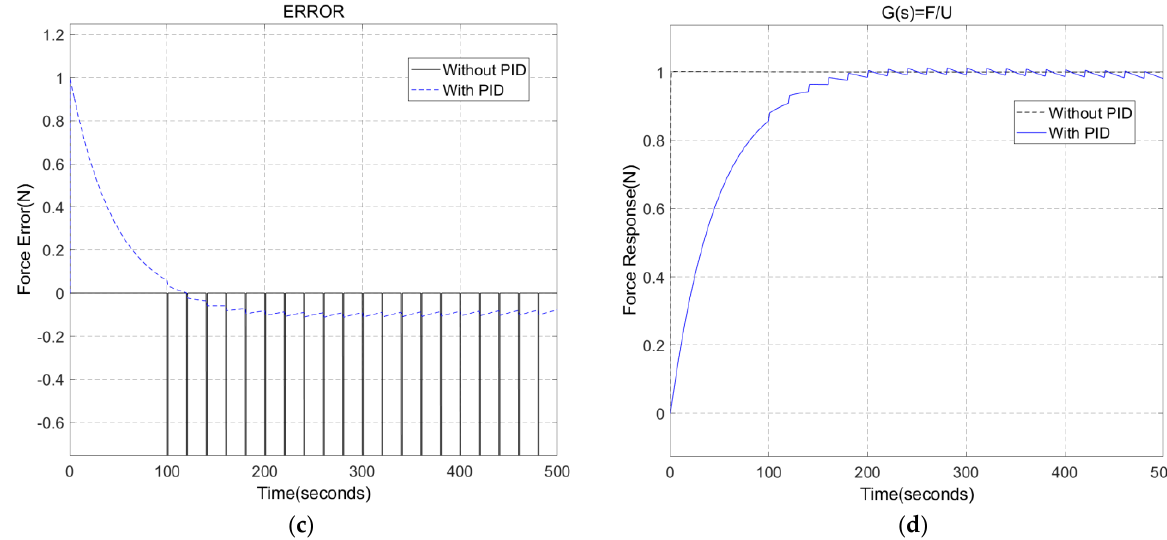
Figure 19 . Force response curves with interference. ( a ) Interference signal; ( b ) Force response curves with interference; ( c ) Error curves with and without PID control; ( d ) Comparison of PID control response curves with and without interference.